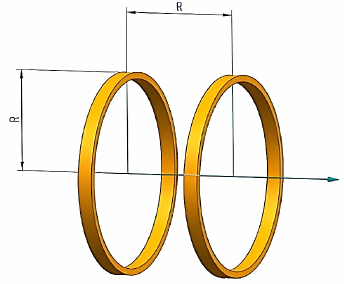
Figure 1. Standard Helmholtz coil structure.